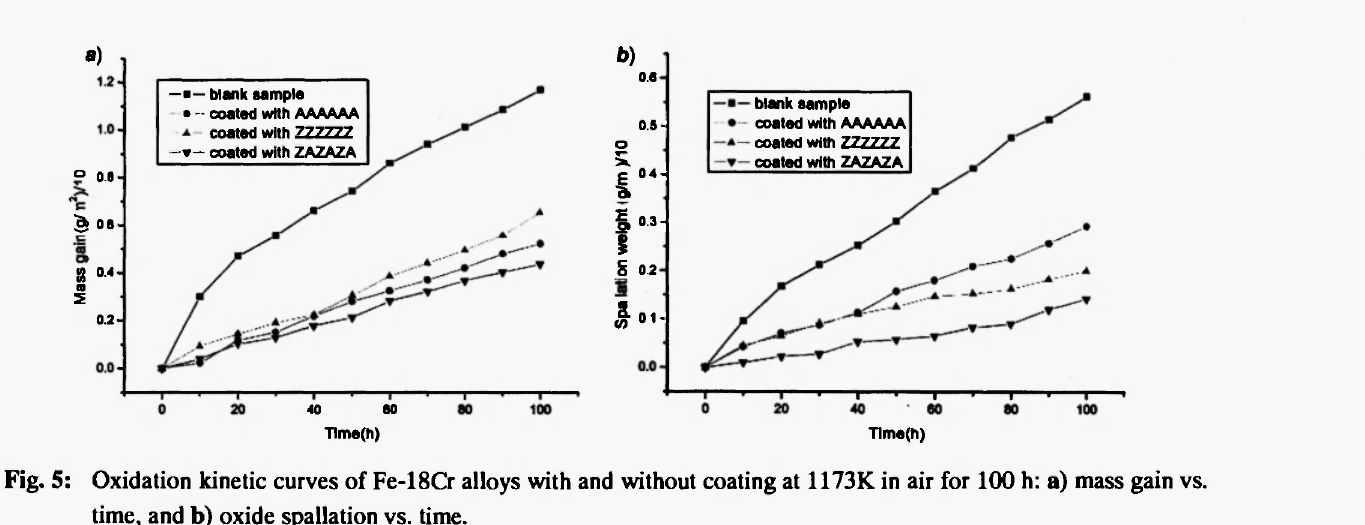
Fig. 5: Oxidation kinetic curves of Fe-18Cr alloys with and time, and b) oxide spallation vs.